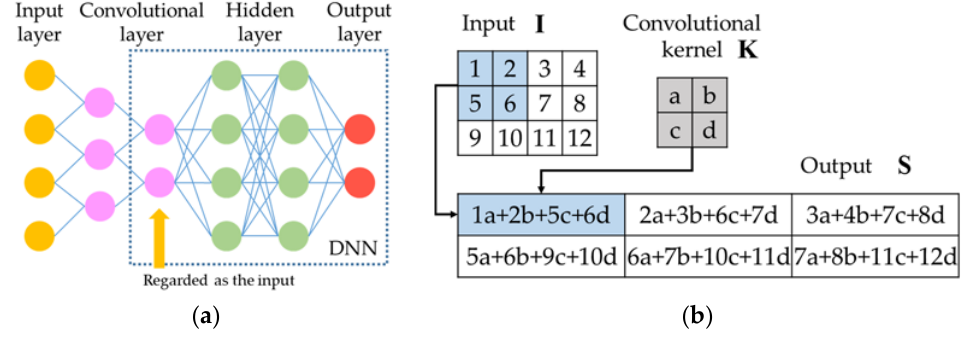
Figure 3. Diagrams of the CNN structure and the discrete convolution: ( a ) CNN structure; ( b ) discrete